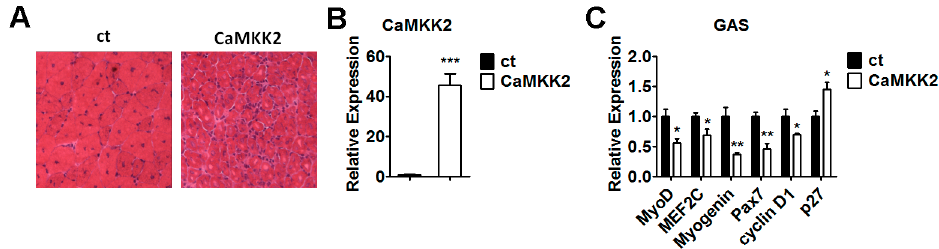
Figure 7. CaMKK2 inhibits muscle regeneration in mice. ( A ) H&E staining of regenerating gastrocnemius muscles from mice after electroporation with CaMKK2 and control plasmids at 14 days following freeze injury; ( B ) Quantitative RT-PCR analysis of CaMKK2 mRNA levels in gastrocnemius muscles (GAS) after electroporation with CaMKK2 and control plasmids at 14 days following freeze injury; and ( C ) Quantitative RT-PCR analysis of MyoD, MEF2c, Myogenin, Pax7, cyclin D1 and p27 mRNA levels in gastrocnemius muscles (GAS) after electroporation with CaMKK2 and control plasmids at 14 days following freeze injury ( n = 3). Means ± SEM (error bars) are shown. *, p < 0.05; **, p < 0.01; ***, p < 0.001.